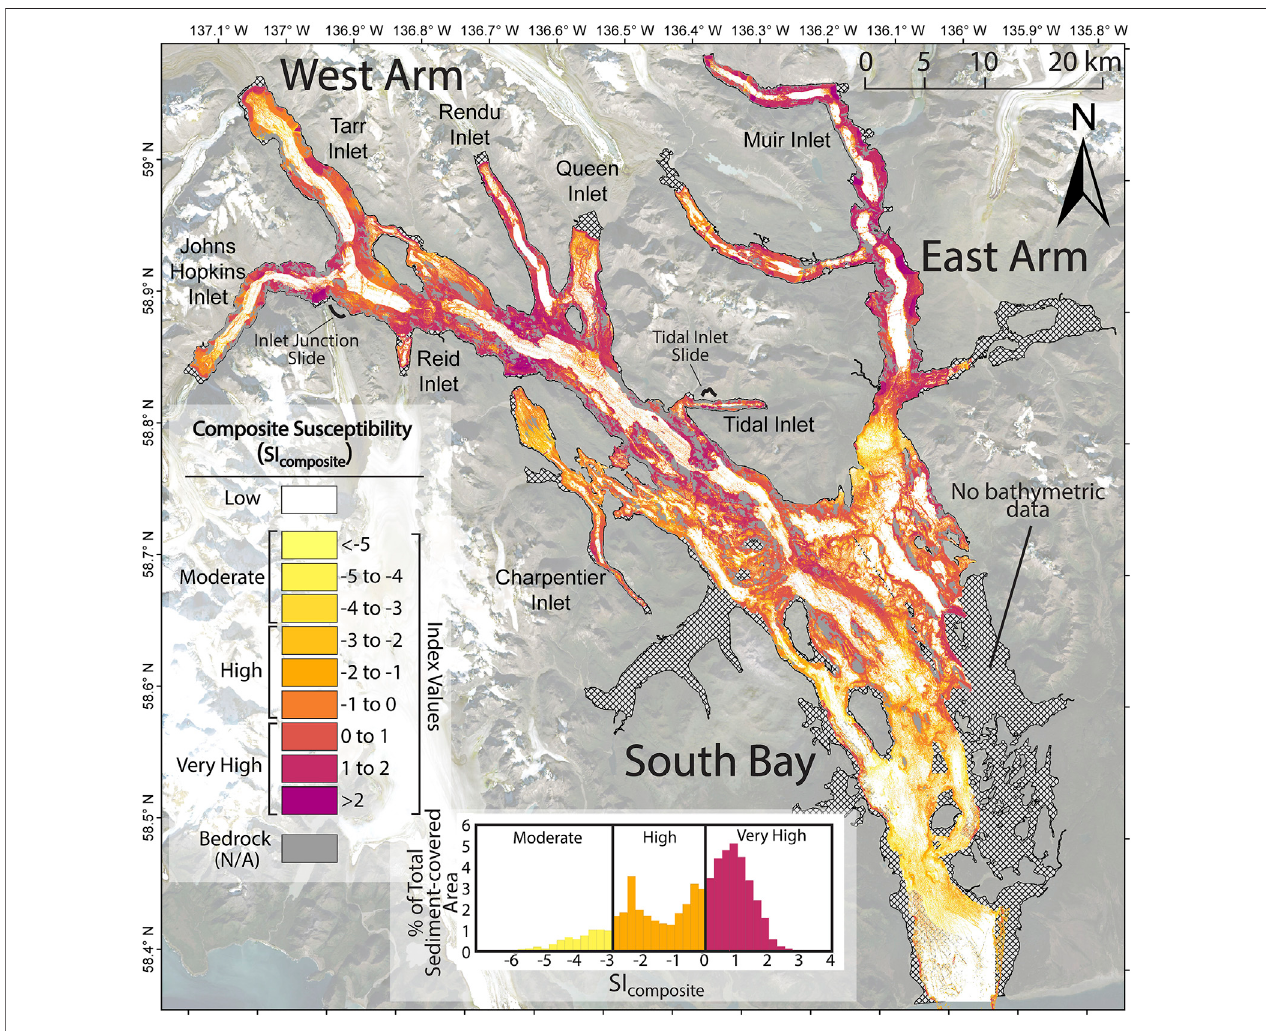
FIGURE 11 | Final composite (SI composite ) submarine landslide susceptibility map for sediment-covered areas in Glacier Bay. Final map shows an additive equally weighted composite of slope-based susceptibility index ( Figure 10A ), fan and delta index susceptibility value of 1 (locations shown in Figure 3B ), and inventory-based susceptibilityindex( Figure10B ).SusceptibilityclassesarebasedonSI composite valuesformoderate(SI composite < − 3),high( − 3 < SI composite < 0),andveryhigh(SI composite > 0).Areasunder2 ° slopewereautomaticallyattributedtothe “ Low ” susceptibilityclass.Althoughweobservednolandslidesinareasunder2 ° slopeinGlacierBay, we attributed a susceptibility category to these areas because of previously documented submarine landslides in low-sloping submarine terrain (e.g., Masson et al., 2006).Bedrock was not given a susceptibility value as our method explicitly addresses landslide susceptibility in soft marine sediment. Areal distribution of susceptibility classes expressed as a percentage of total sediment-covered area reveal the highest total percent of grid cells in “ Low ” (39%), followed by “ Very High ” (34%), “ High ” (22%), and “ Moderate ” (5%) classes. Histogram below map shows the SI composite distribution for classes “ Moderate ” through “ Very High. ”